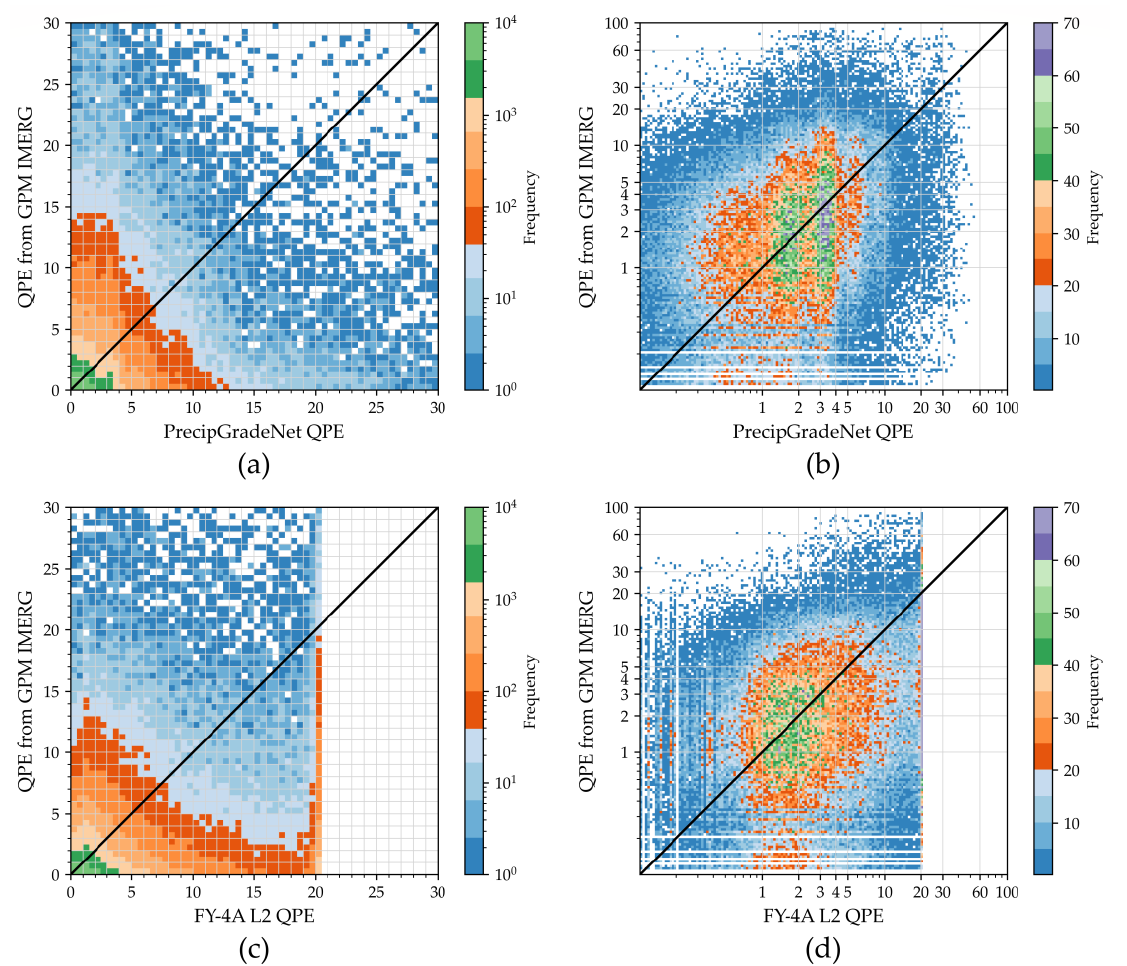
Figure 6. Relationship between PrecipGradeNet precipitation, FY-4A QPE and IMERG precipitation during the test period (from 4 August 2021 to 7 October 2021), with linear axis and logarithmic axis. ( a ) Histogram between precipitation from PrecipGradeNet and IMERG; ( b ) histogram between precipitation from PrecipGradeNet and IMERG in logarithmic scale; ( c ) histogram between precipitation from FY-4A L2 QPE and IMERG; ( d ) histogram between precipitation from FY-4A L2 QPE and IMERG in logarithmic scale.)